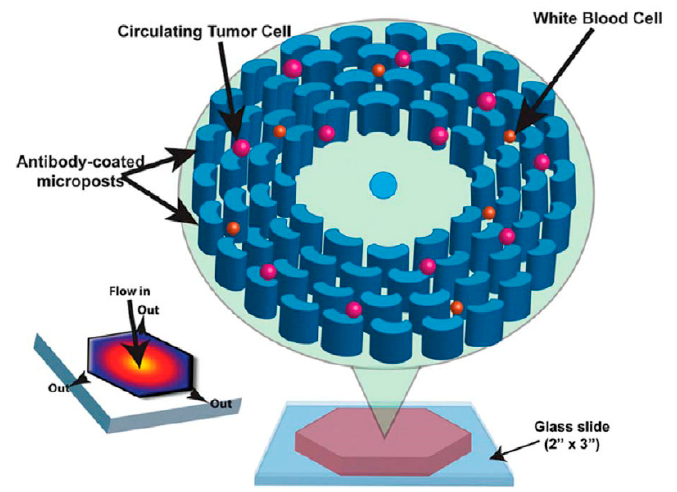
Figure 3. Schematic representation of microfluidics with bean-shaped microposts. The anti-EpCAM (epithelial cell adhesion molecules) antibodies were coated on the surface of bean-shaped microposts. The circulating tumor cells (pink dots) were captured by antibodies. Adapted from Murlidha et al. [25]. Copyright 2014 Wiley Online Library, 2014.